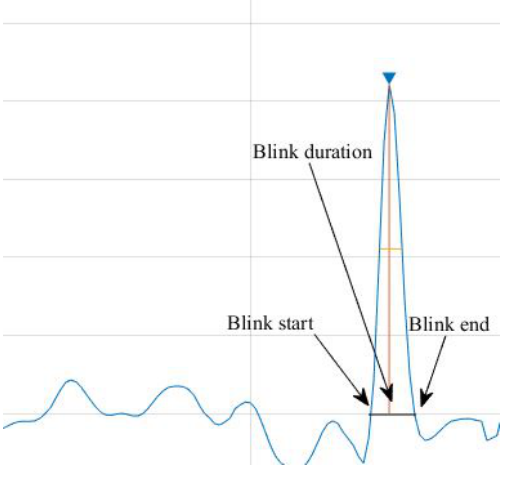
Figure 6. Blink duration illustration. Table 3. Blink statistics: GT (ground-truth blinks), DB (detected blinks), RGT (ground truth blink rate), RD (detected blink rate), and Duration (average blink